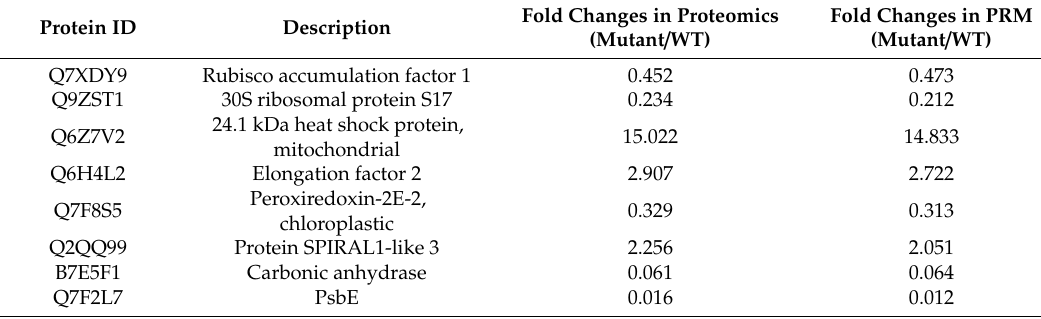
Table1. Table 1. Confirmation of Daps in Proteomic Analysis Using parallel reaction monitoring (PRM) Analysis.